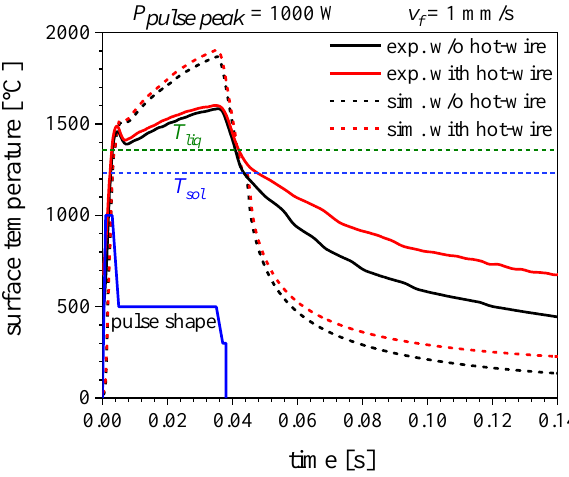
Figure 6. Comparison of numerical and experimental transient temperature curves.